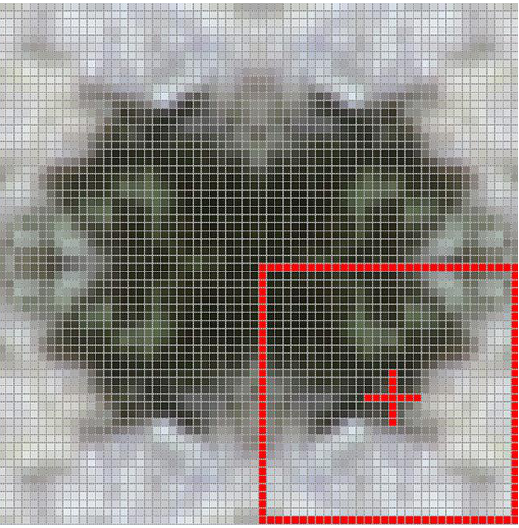
Figure 7. Even extension of the 32 × 32 neighborhood (framed) of the pixel processed (cross). Taken from [27].